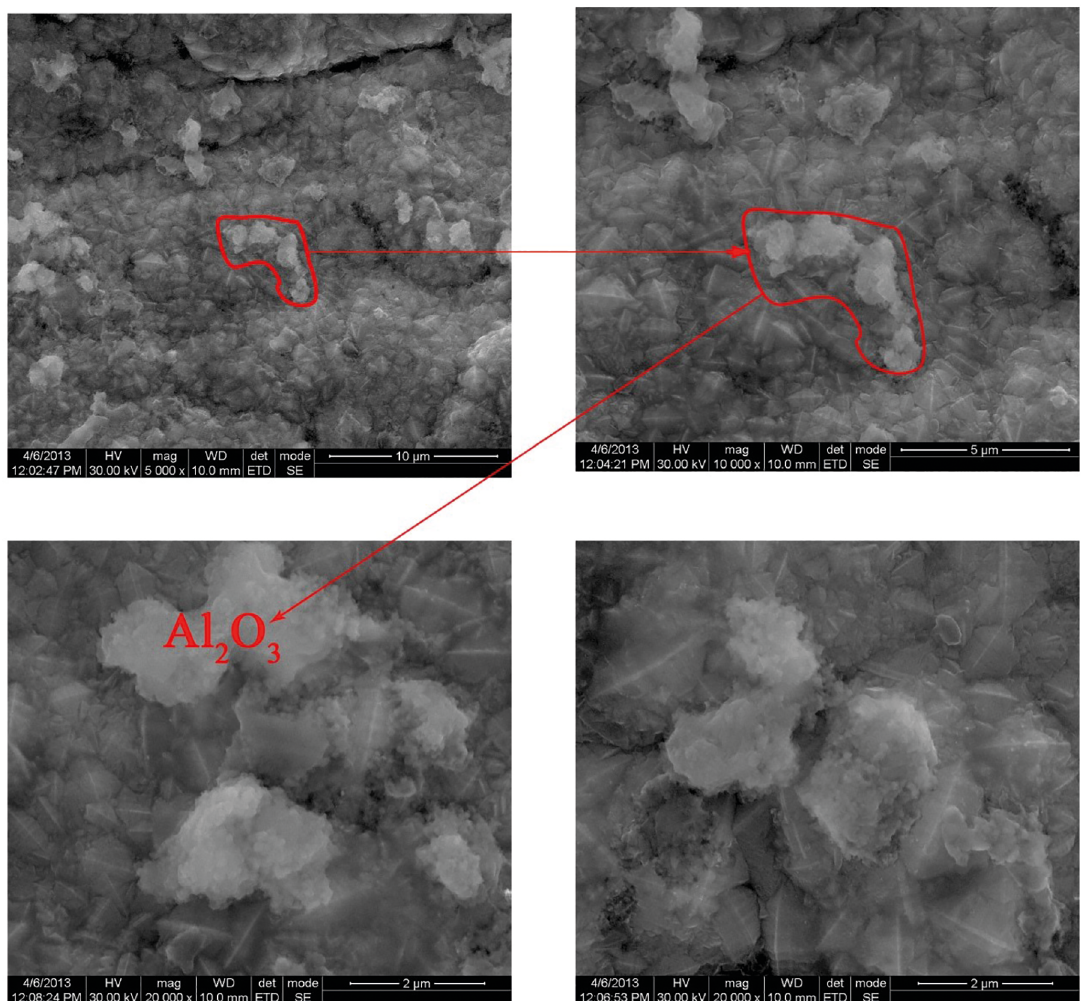
O composite coatings of optimized cast iron cylinder liner. 2 3